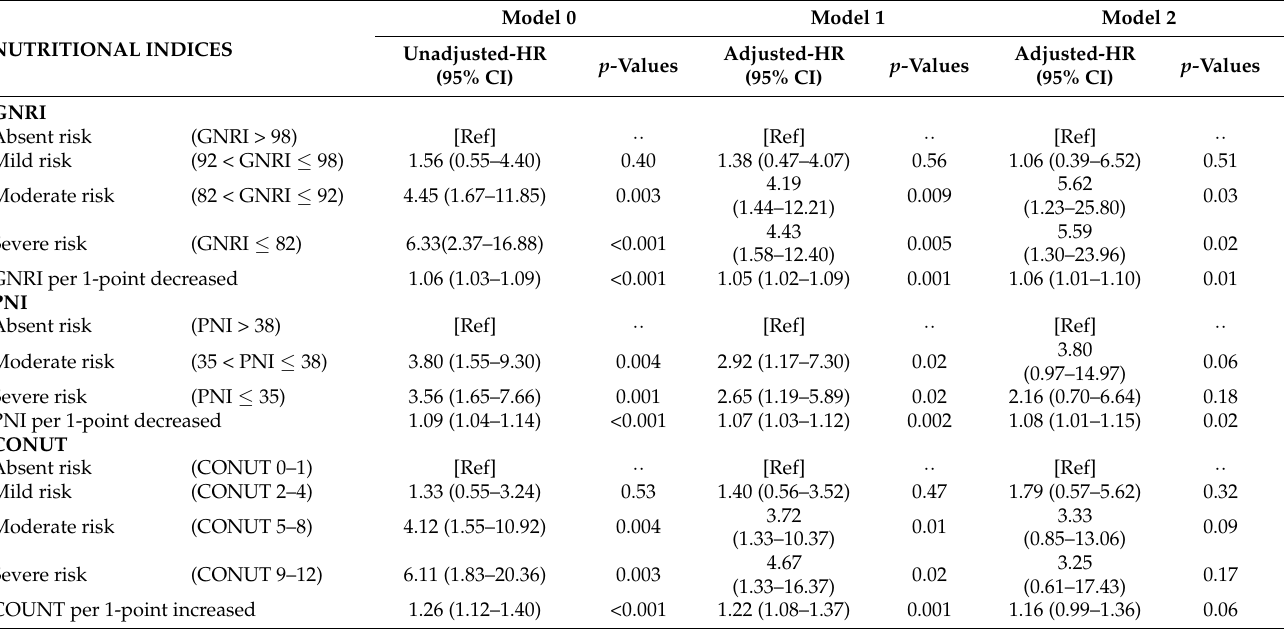
Table 3. Univariable and multivariable Cox regression of the impact of nutritional status on all- cause